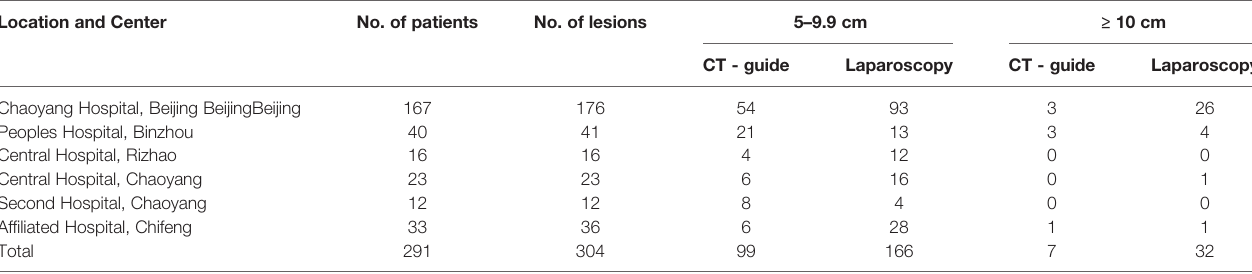
TABLE 1 | Summary of patients and lesions treated with RFA according to location and center. Location and